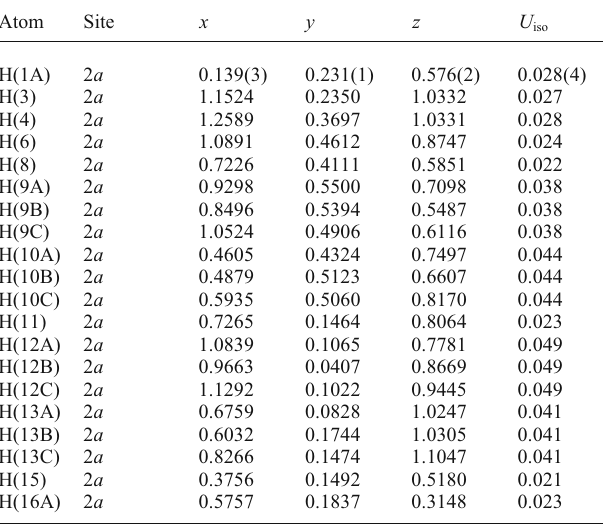
Table 2. Atomic coordinates and displacement parameters (in Å 2 )